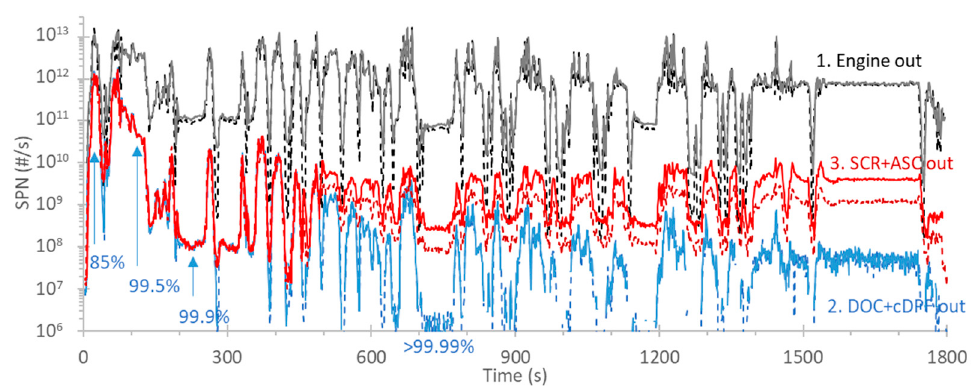
Figure 2. Cold start world harmonized vehicle cycle (WHVC) at 23 °C. The different colors represent different sampling locations. Continuous lines indicate solid particle numbers >10 nm, SPN 10 ; dotted lines indicate >23 nm, SPN 23 , emissions. ASC = ammonia slip catalyst; DOC = Diesel oxidation cata- lyst; cDPF = catalyzed Diesel particulate filter; SCR = selective catalytic reduction.